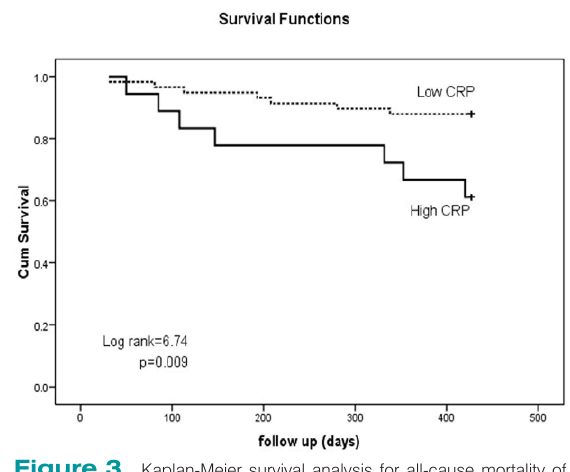
Figure 3. Kaplan-Meier survival analysis for all-cause mortality of CRP. Patients were divided into two groups: low CRP (first and second tertiles) – dotted line; high CRP (highest tertile) – solid line.